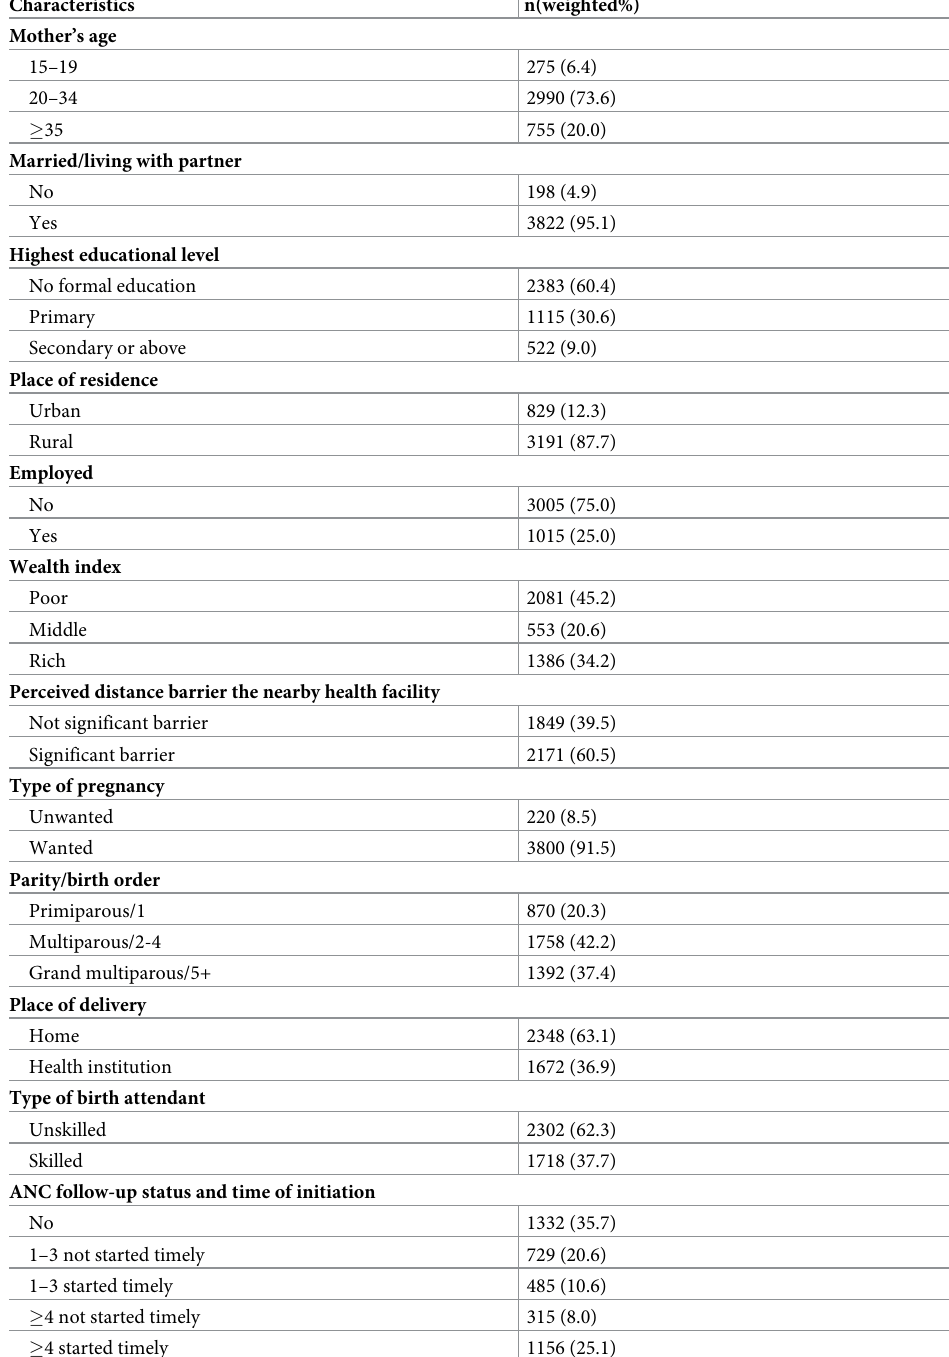
Table 1. Descriptive statistics of women who gave birth in the 2 years before the survey, Ethiopia, 2016 DHS (N =